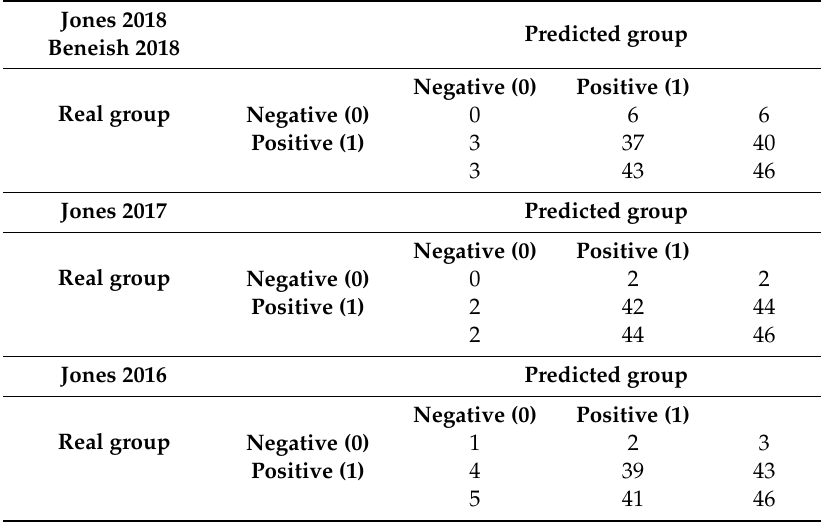
Table 7. Confusion matrix in the analyzed period.